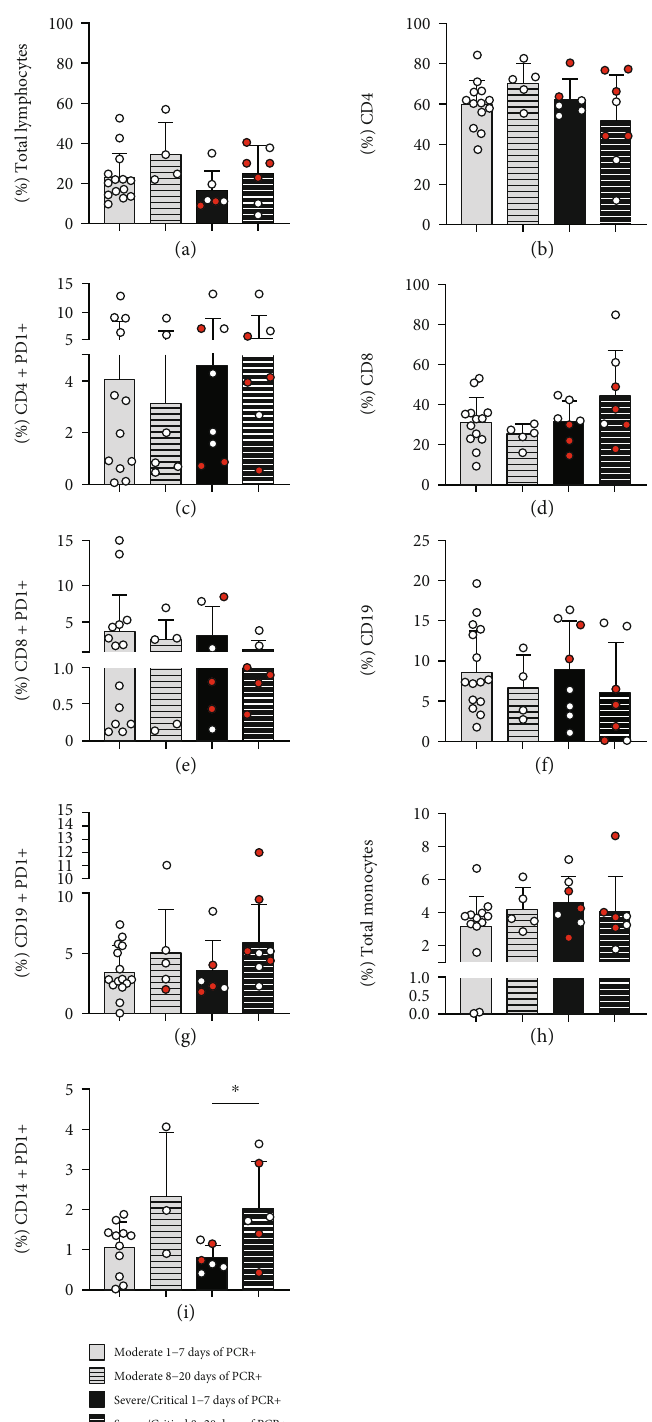
Figure 2: Increased expression of PD-1 on CD14+ monocytes is associated with the duration of SARS-CoV-2 infection. Frequency of total lymphocytes (a), CD4+ CD3+ T-cells (b), CD4+ PD-1+ T-cells (c), CD8+ CD3+ T-cells (d), CD8+ PD1+ T-cells (e), CD19+ cells (f), CD19 + PD-1+ cells (g), total monocyte frequency (h), and CD14+ PD-1+ cells (i) assessed by fl ow cytometry in peripheral blood samples of control subjects ( n = 8 ) and patients in moderate ( n = 18 ), severe (open symbol n = 7 ), and critical (red symbol, n = 7 ) clinical status. ∗ P < 0 : 05